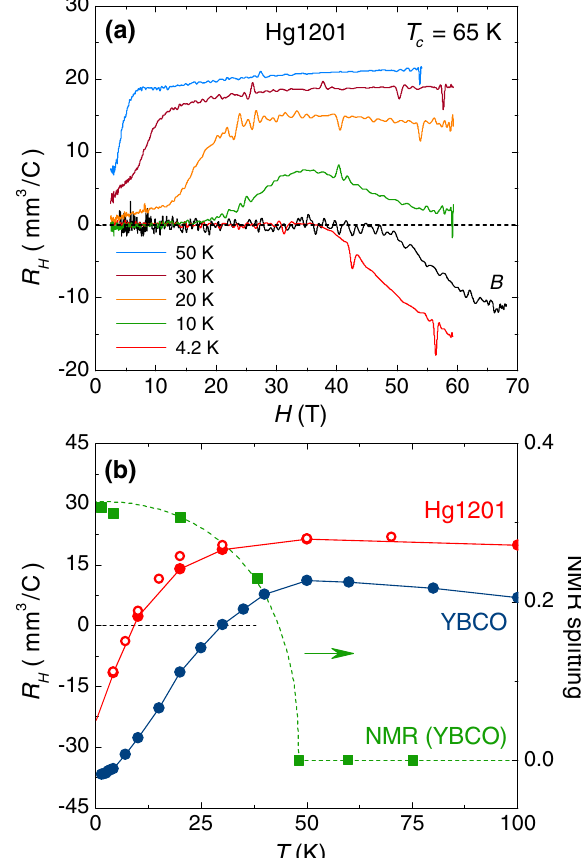
FIG. 1. (a) The Hall coefficient R H of Hg1201 as a function of magnetic field H , in sample A at various temperatures, as indicated. Also shown is an isotherm at T ¼ 4 : 2 K , measured on sample B (black curve, labeled B ). (b) Normal-state Hall coefficient R H as a function of temperature, at H ¼ 53 T (sam- ple A ; closed red circles, left axis) and H ¼ 68 T (sample B ; open red circles, left axis). Corresponding data are shown for YBCO at p ¼ 0 : 10 and H ¼ 55 T (blue circles, left axis; from Ref. [10]). Note how in both materials, R H ð T Þ drops at low temperature to become negative, a signature of Fermi-surface reconstruction [12]. We reproduce the splitting of NMR lines in YBCO at p ¼ 0 : 10 and H ¼ 28 : 5 T , which reveals the onset of ’ 50 K (green squares, right axis; from charge order below T CO Ref.